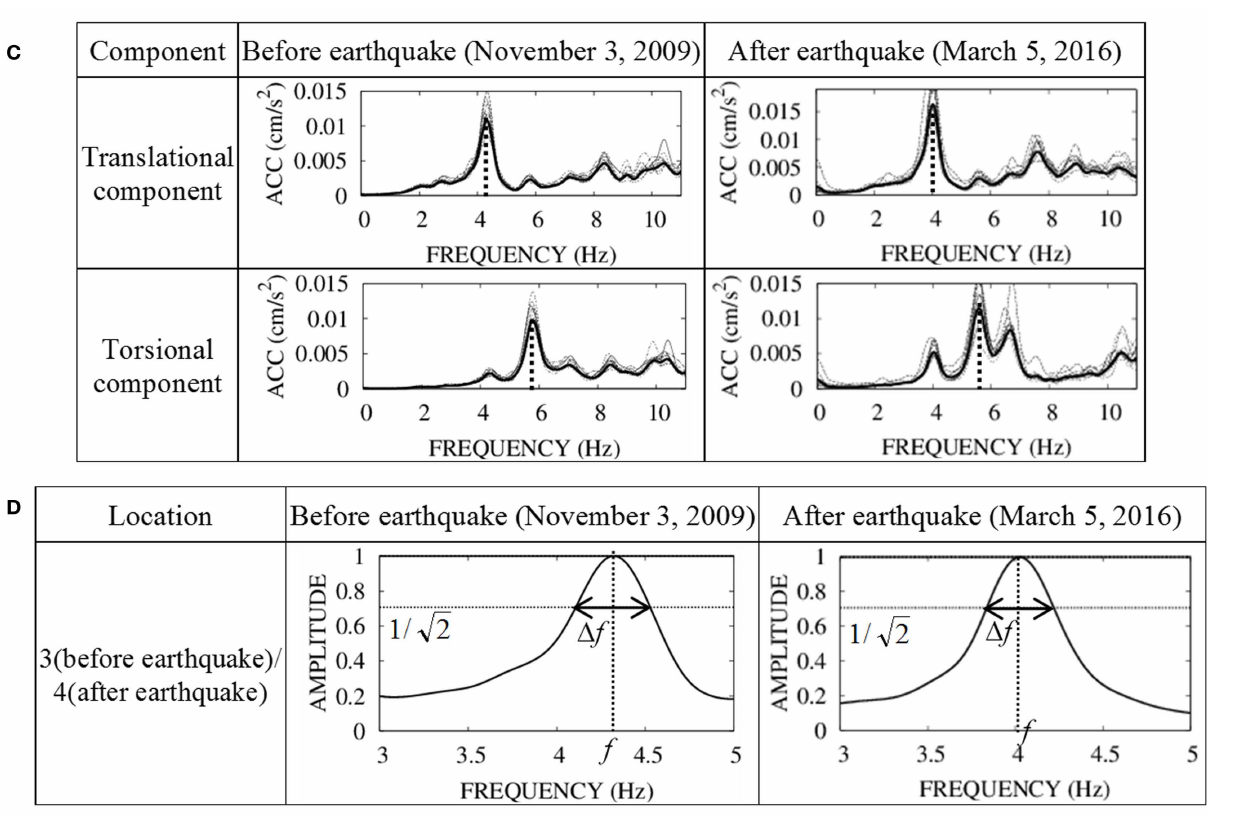
FIGURE 6 | Continued Comparison of ambient vibration of the building before and after the 2015 Gorkha earthquake. (A) Longitudinal ( x , NS) direction. (B) Transverse ( y , EW) direction. (C) Translational and torsional components in the transverse ( y , EW) acceleration. (D) Damping ratio estimation based on the half-power method.